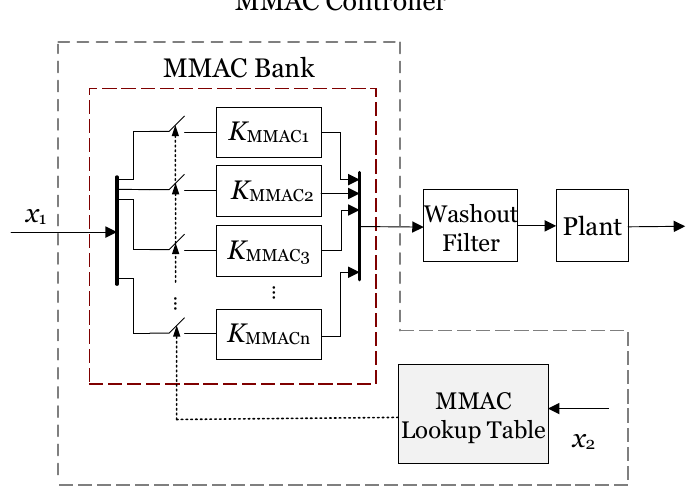
Figure 2. Schematic diagram of multiple-model adaptive control (MMAC)